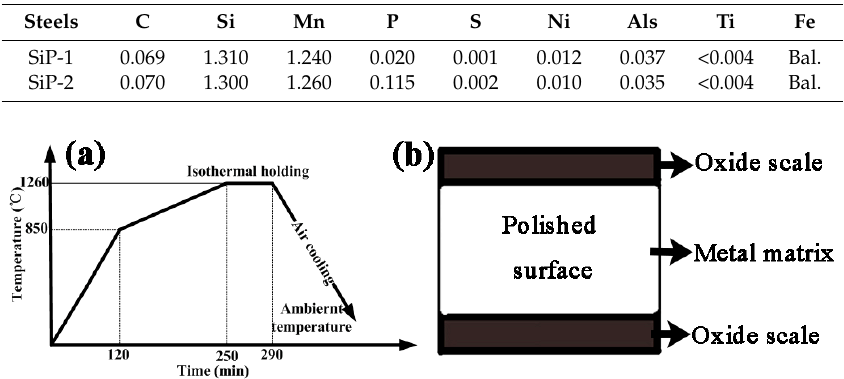
Table 1. The chemical compositions of the tested steels (wt %).